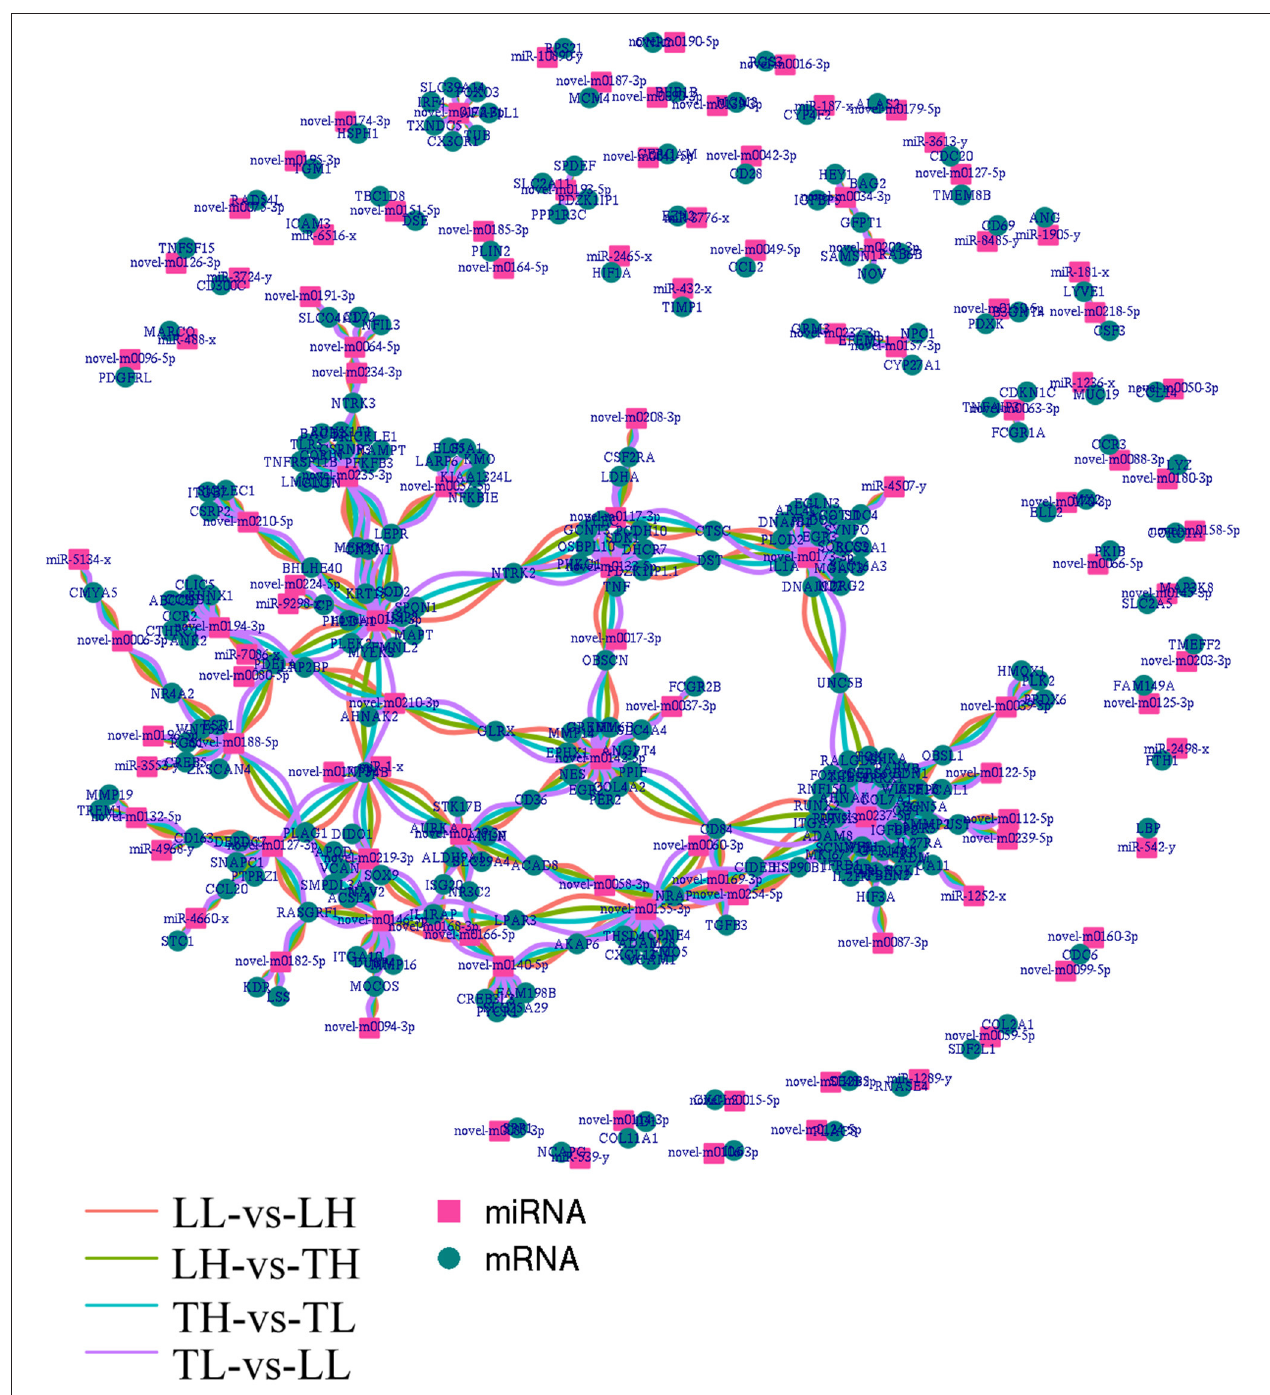
FIGURE 7 | Integrated miRNA-target negative correlation regulatory network. The square nodes represent miRNAs, and the circle nodes represent target genes. The differentially expressed miRNAs/target genes are highlighted as follows: red indicated differential expression between Landrace pigs raised in lowlands (LL) and Landrace pigs raised in highland (LH), green indicates differential expression between LH and Tibetan pigs raised in highland (TH), blue indicates differential expression between TH and Tibetan pigs raised in lowland (TL), and purple indicates differential expression between TL and LL. Marquard and Jücker, 2020). The FOXO signaling pathway processes, including activating mTOR, localizing FOXO to the cytoplasm, and activating cAMP-response element binding was also enriched in a comparison of pigs living at different protein (CREB) (Zhang et al., 2011; Gaecía-Morales et al., 2017; altitudes. It has been shown that alcohol suppresses